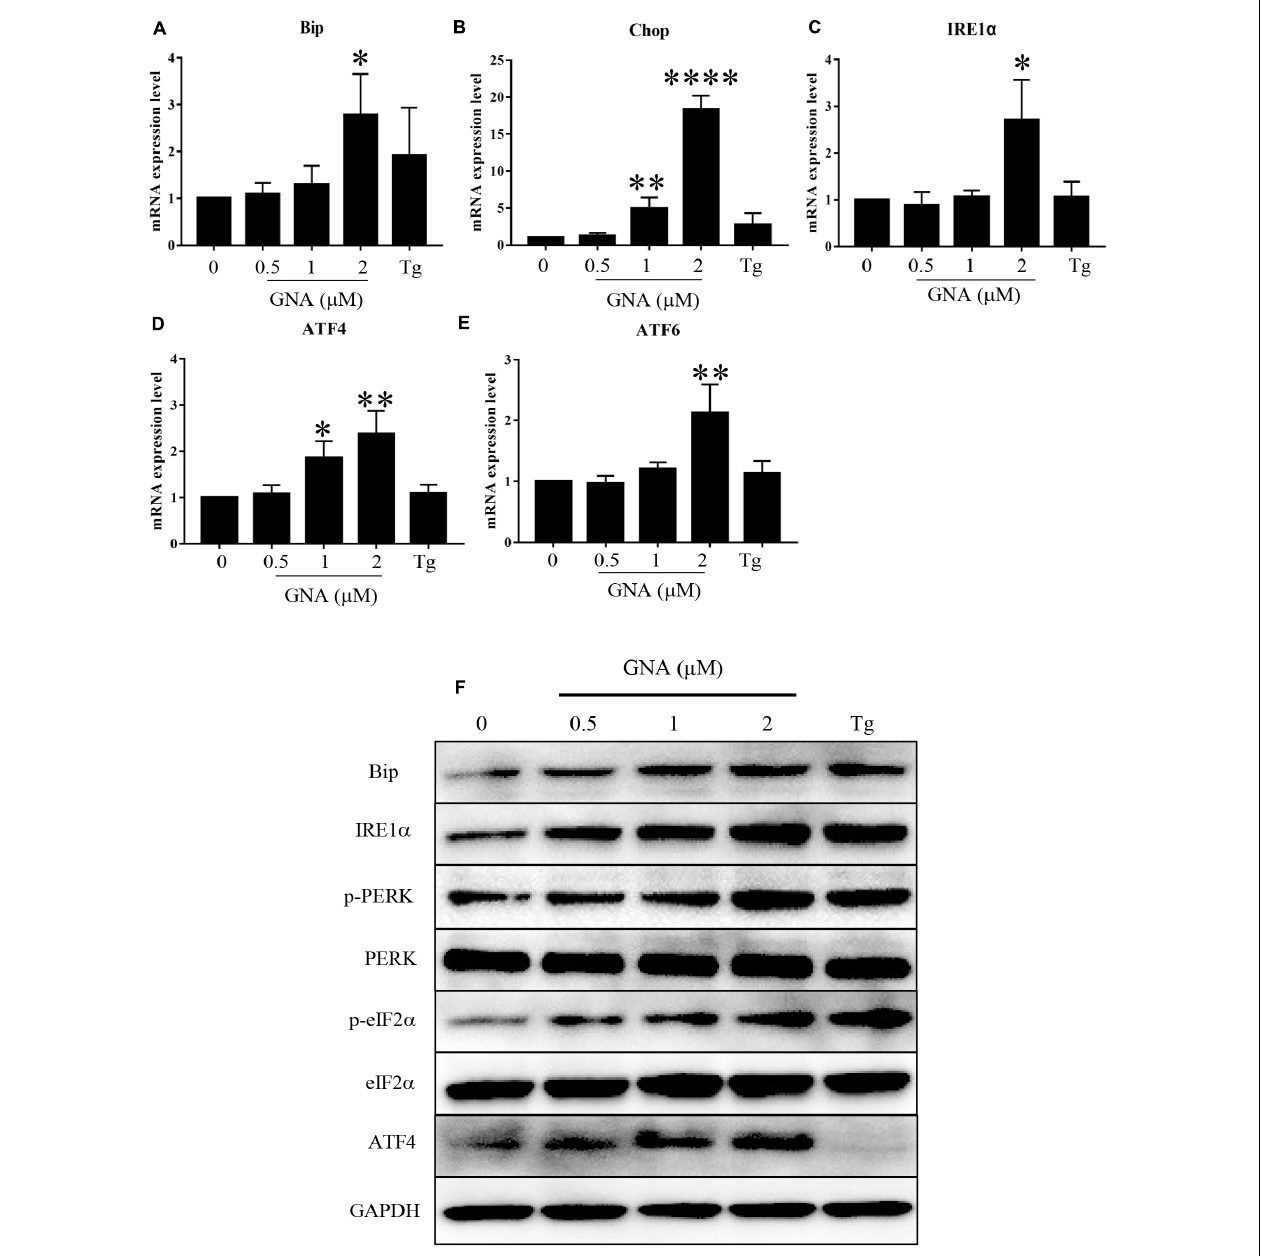
FIGURE 3 | GNA promoted UPR in cells. HCT116 cells were treated with different concentrations of GNA (0.5, 1, 2 µ M) and thapsigargin (1 µ M) for 6 h. (A–E) Total mRNA was extracted, and real-time PCR was used to measure the mRNA expression levels of Bip (A) , Chop (B) , IRE1 α (C) , ATF6 (D) , ATF4 (E) . (F) The expression of BIP, IRE1 α , p-PERK, PERK, p-eIF2 α , eIF2 α , and ATF4 was analysed by western blotting. GAPDH was used as a loading control. The data are presented for at least three independent experiments. The data are presented as the mean ± SD. * P < 0.05; ** P < 0.01 and **** P < 0.0001.